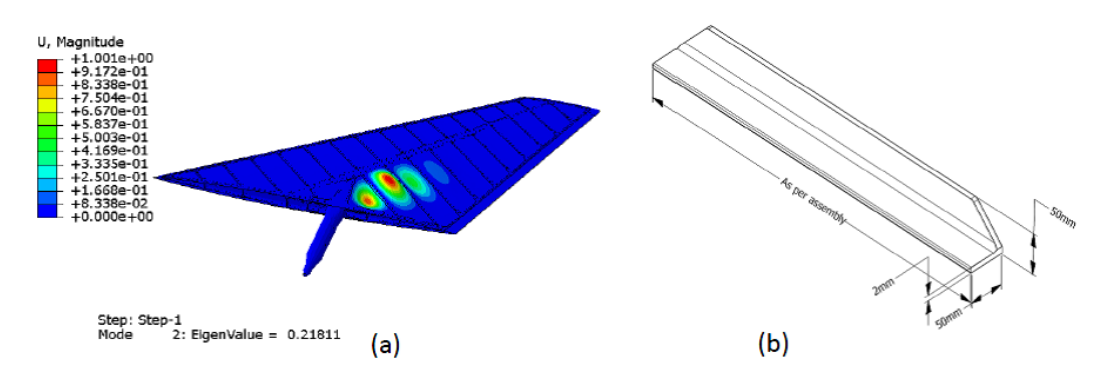
Figure 5: (a) Buckling Mode Plot of CFC Structure (b) A Proposed Buckling